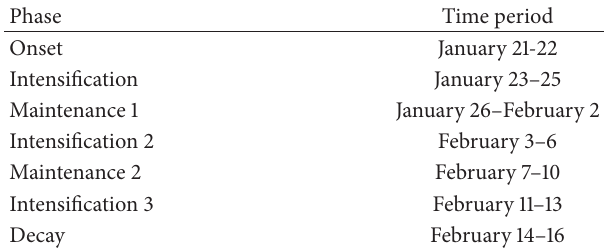
Table 1: Time periods of the blocking event partitioned using the BI.